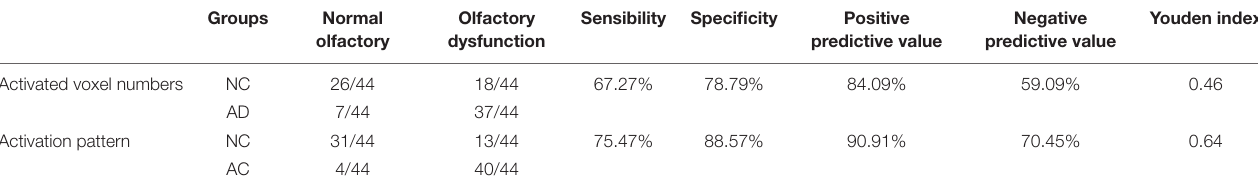
TABLE 4 | The diagnostic efficiency of activation pattern vs activated voxel numbers of POC.